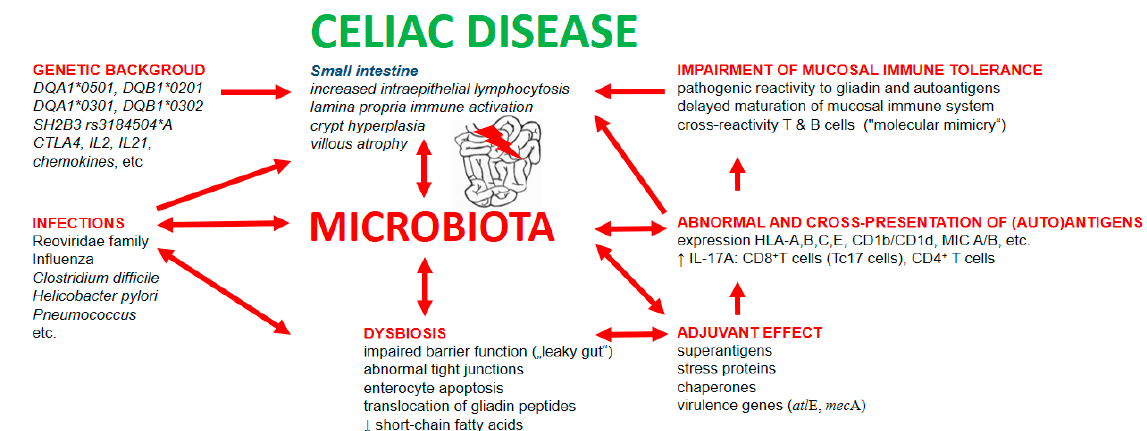
Figure 2. Involvement of infections and dysbiosis in pathogenesis of celiac disease. Infectious components possess the capability to non-specifically stimulate the immune system via: (1) adjuvant properties of bacterial and viral molecules; (2) stimulation of expression of classical and non-classical MHC molecules; (3) stimulation of antigen presentation, including cross-presentation of gliadin and autoantigens; (4) capacity of cross-reactivity of adaptive immune cells induced by mechanism of “molecular mimicry”; and (5) disruption of gut mucosal barrier leading to increased intestinal permeability for luminal food and bacterial antigens and thus elevated antigenic load in mucosal layer of small intestine.